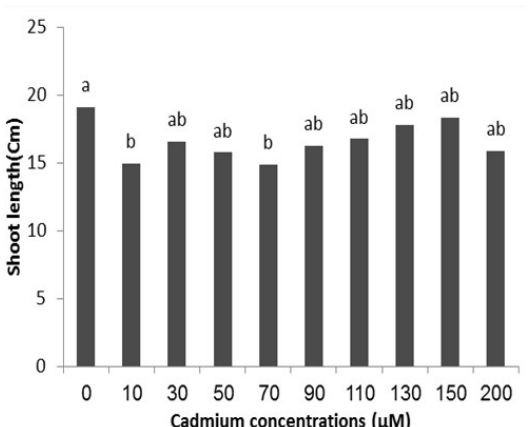
Fig. 1 . Effects of cadmium on shoot length of Brassica napus L.